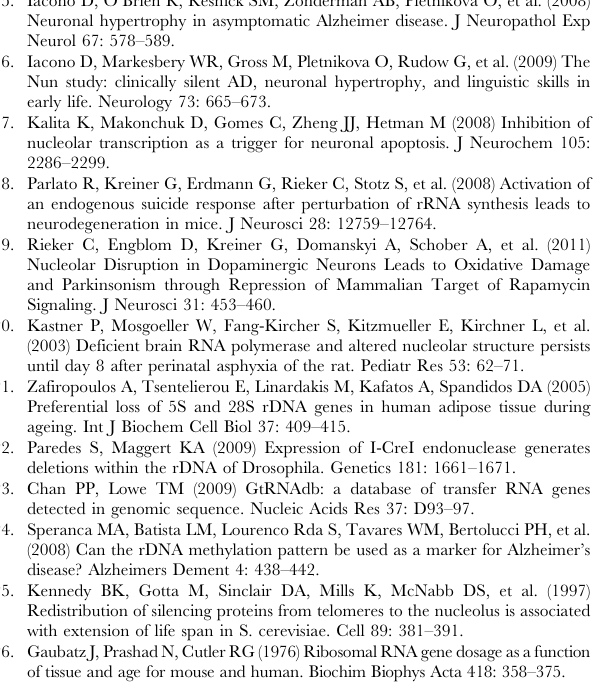
more details, see Figs. 1&3). Figure S2 Effects of AD on mC content of the rDNA promoter in the AD pathology-free cerebellum. A , Average % mC in the rDNA promoter (% rDNA methylation). Individual values are depicted by squares; mean values are indicated by the lines intersecting the error bars (SEM); p values and numbers of analyzed cases (n) are indicated. In the AD- affected prefrontal cortex, the rDNA promoter is hypermethy- lated. B , The distribution of differentially methylated rDNA promoter clones indicates overrepresentation of hypomethylated rDNA units in control samples (p , 0.001). Similar pattern is present in AD. For more details, see description of the Fig. 2. Figure S3 Effects of MCI and AD on mC content in total genomic DNA as determined with an mC-specific ELISA. A , In parietal cortex, neither MCI nor AD affected mC content in total genomic DNA (global DNA methylation). B–C , AD had also no effects on that parameter in the prefrontal cortex (B) or the cerebellum (C). Individual values are depicted by squares; mean values are indicated by the lines intersecting the error bars (SEM); p values and numbers of analyzed cases (n) are shown. Figure S4 Effect of AD on distribution of CpG methyl- ation across the rDNA promoter in the cerebellum. A , Percent methylation at each of 26 individual CpG sites located in the rDNA promoter region. The data represent averages 6 SEM from 5 AD- and 5 non-AD control individuals; *, p , 0.05 (SAM statistics). B , Local regression analysis of the AD effects on rDNA promoter methylation in the cerebellum. Mean differences between AD- and control groups are plotted. The circles indicate